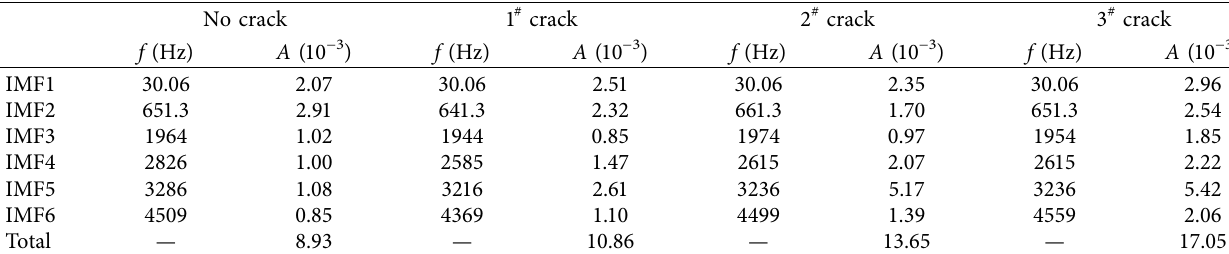
Table 8: Central frequency and amplitude of each IMF for 3 #